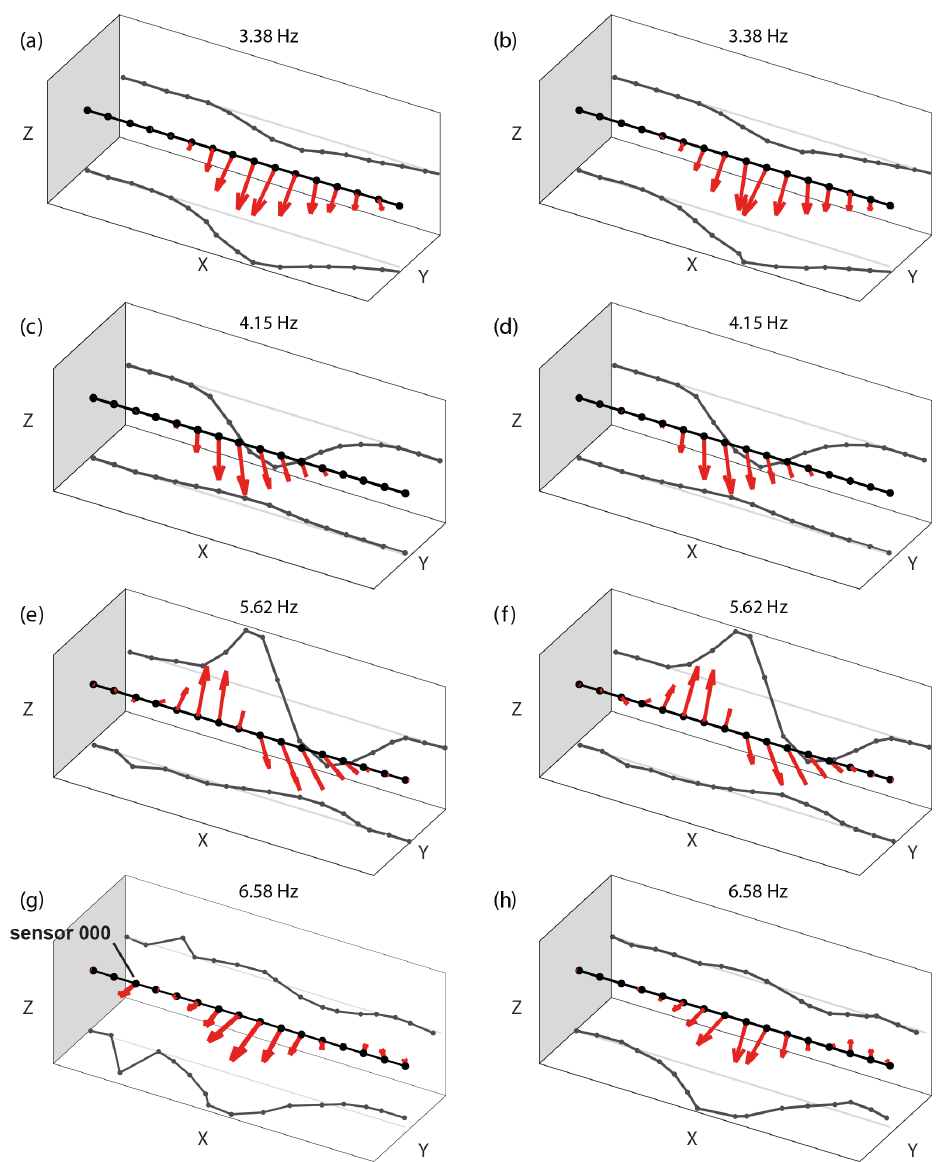
Figure A2. 3D mode shapes of Musselman Arch for the two parallel lines of geophones and projections onto the X – Y and X – Z planes. The geophone line shown on the right is shown in Fig. 5d–g in the main article. The mode shapes of the parallel lines are nearly identical.